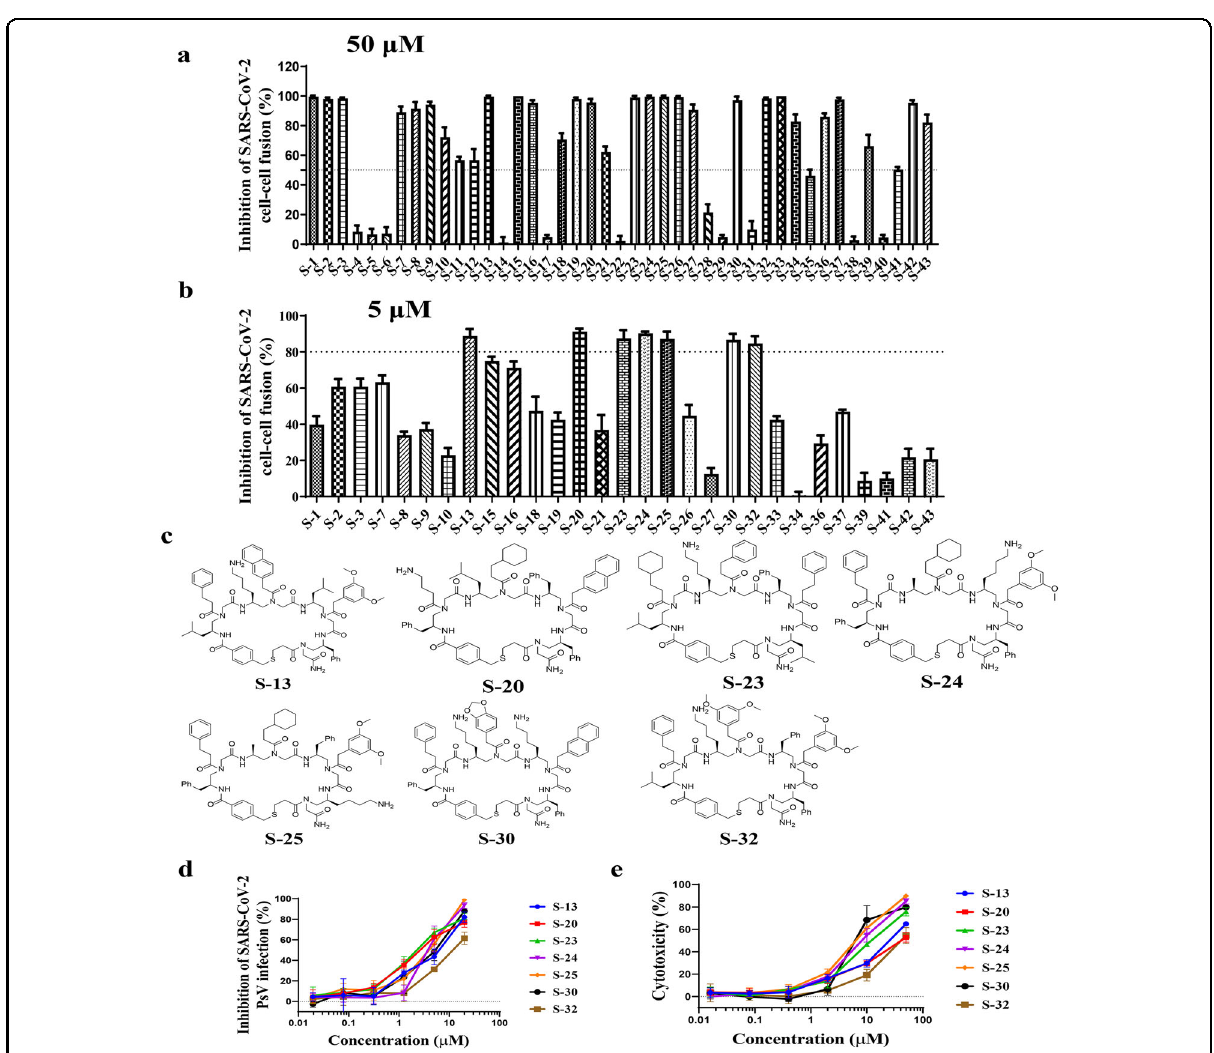
Fig. 1 Screening for SARS-CoV-2 fusion and entry inhibitors from a cyclic γ -AApeptide library. Inhibition of cell – cell fusion mediated by the S protein of SARS-CoV-2 by putative hits at 50 μ M ( a ) and 5 μ M ( b ). The dot line in fi gures means the inhibition rate of 50% ( a ) and 80% ( b ). c Chemical structures of seven hits with inhibitory effect against SARS-CoV-2 S-mediated cell – cell fusion. d Inhibitory activity of hits ( S-13 , S-20 , S-23 , S-24 , S-25 , S-30 , and S-32 ) from SARS-CoV-2 pseudovirus infection assay. e Cytotoxicity of hits ( S-13 , S-20 , S-23 , S-24 , S-25 , S-30 , and S-32 ) on Huh-7